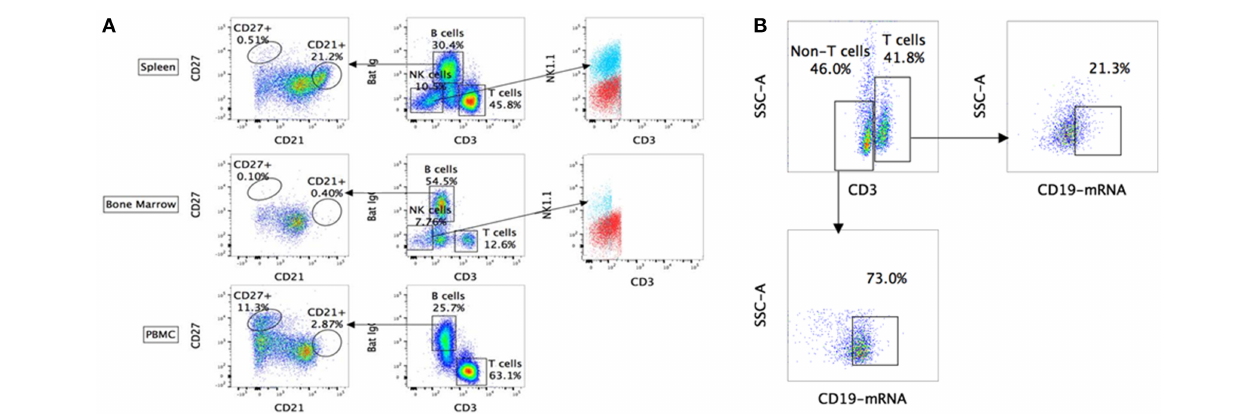
FIGURE 1 | Flow cytometry analysis of P. alecto immune cells using cross-reactive antibodies and Flow-FISH. (A) P. alecto immune cells from spleen, bone marrow and peripheral blood mononuclear cell (PBMC) were analyzed by flow cytometry. CD3 + sIg − cells were identified as T cells while CD3 − sIg − cells as NK cells and CD3 + / − sIg + as B cells. B cell population that was CD27 + was identified as memory cells and CD21 + as mature B cells. CD3 − sIg − cells were further verified using NK1.1 antibody to confirm NK cell population. (B) Detection of B cell subsets by combined Flow-FISH and antibody staining. Bat splenocytes were stained with CD3 antibody followed by in-situ hybridization with probes specific for CD19 mRNA . One data set is shown and is representative of 3 independent experiments performed with 3 different bat bone marrow.